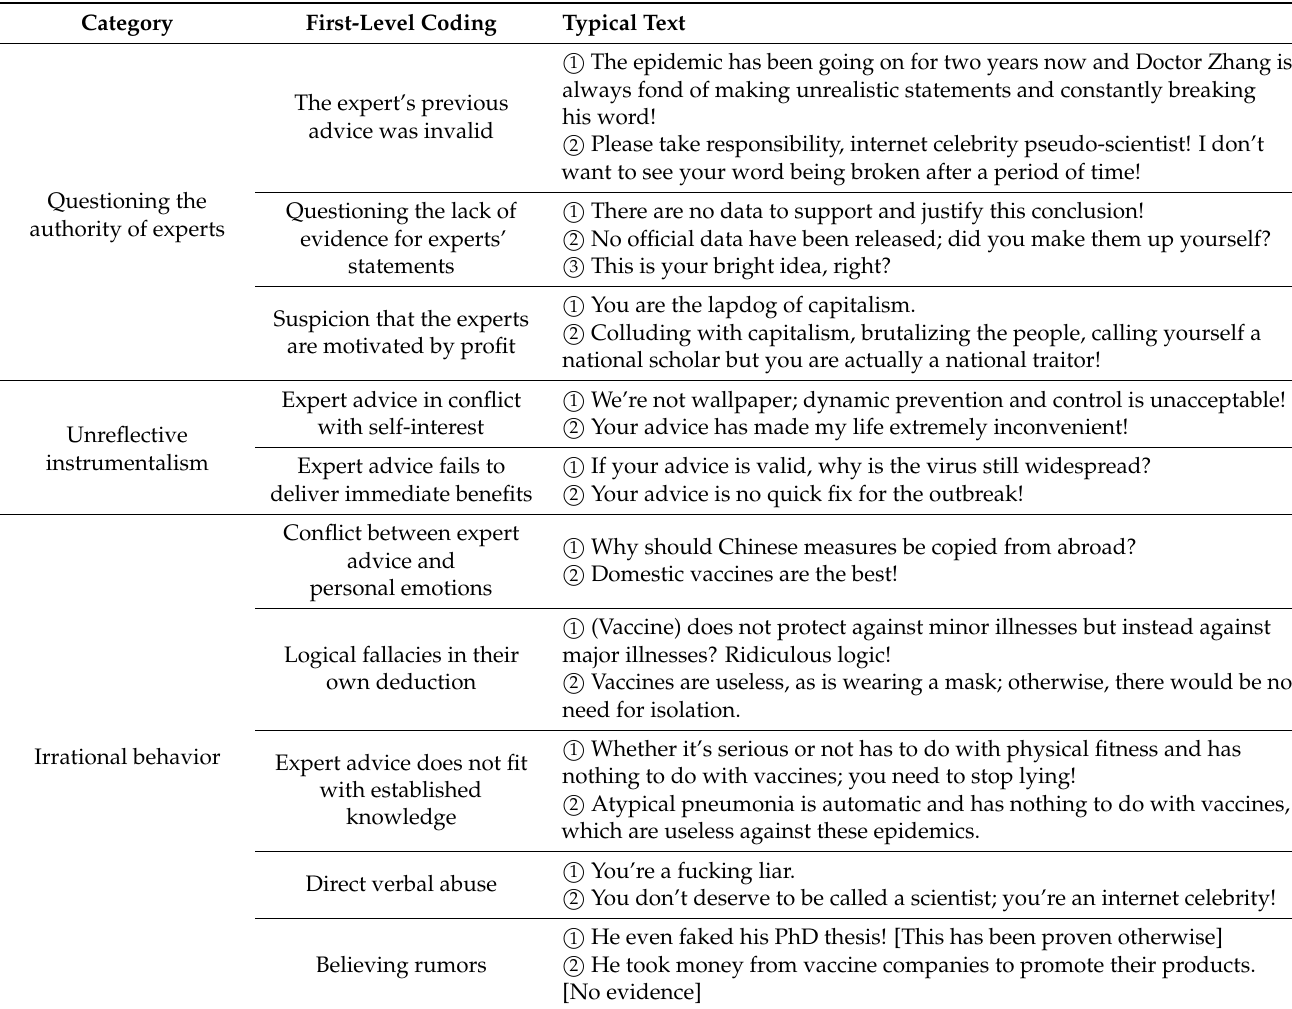
Table 2. Characteristics of anti-intellectual